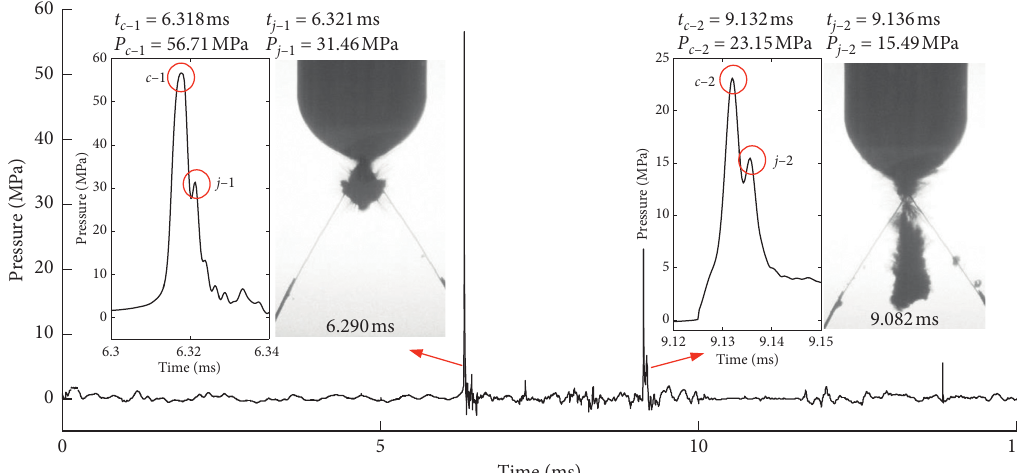
Figure 14: Pressure-time diagram of the first and second cycles of the electric-spark-generated bubble load for c � 0.33.